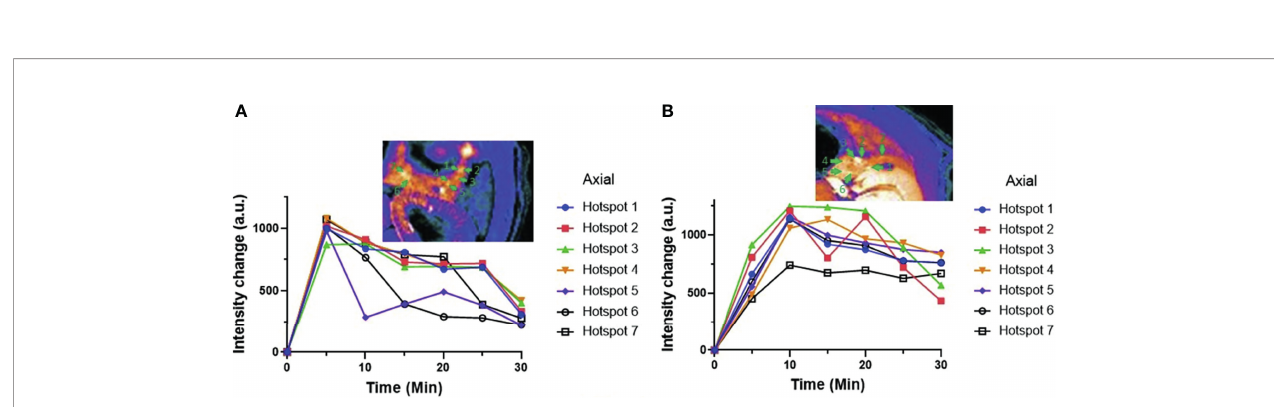
FIGURE 5 | (A) MR signal intensities of individual pancreatic hot spots in control rats versus (B) exenatide treated rats over time. These data are consistent with sustained insulin secretion in animals treated with